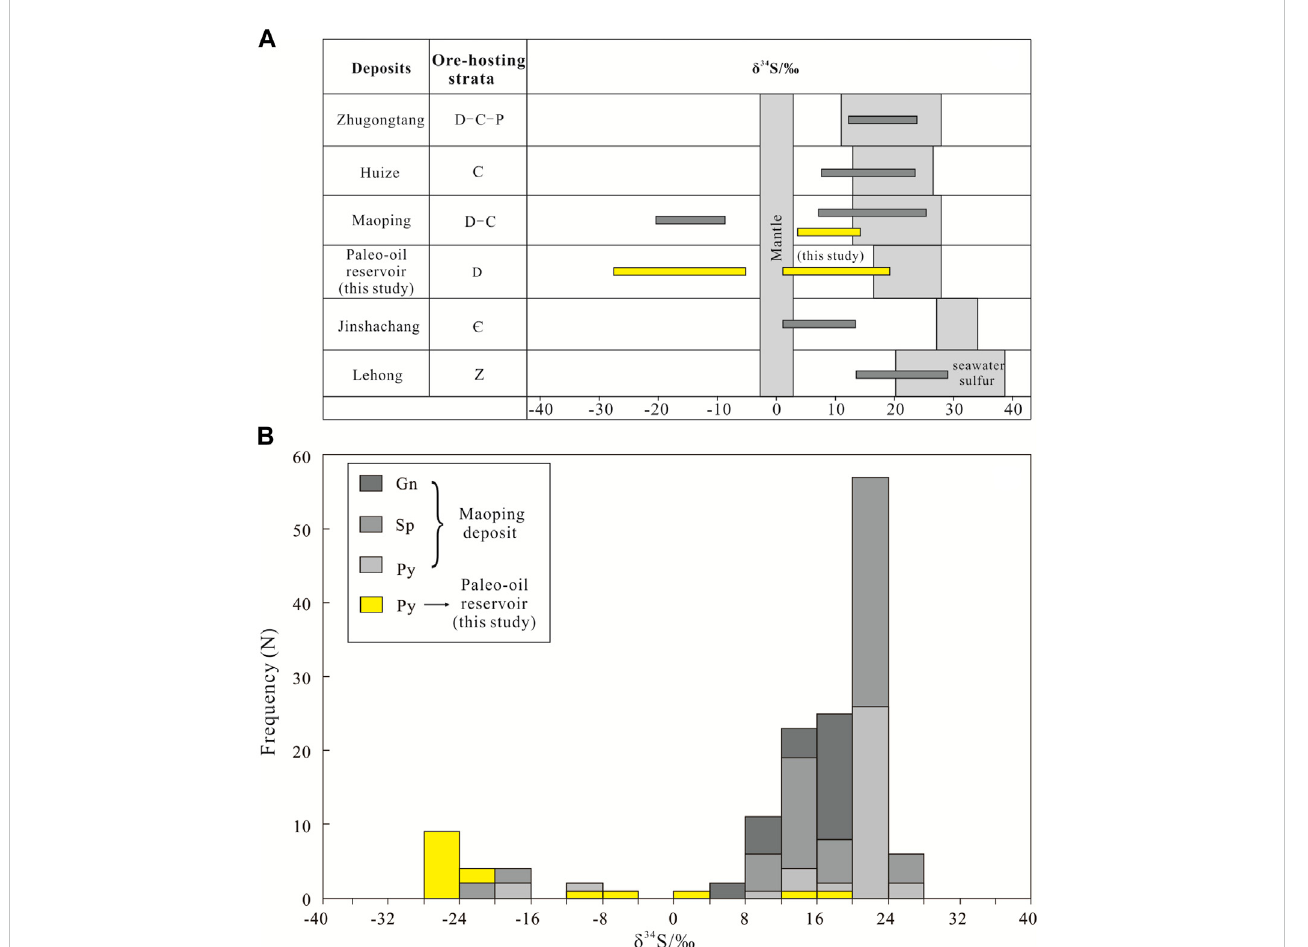
FIGURE 10 (A) ComparisonofSisotopiccompositionsbetweenthePb – ZndepositshostedindifferentstrataagesoftheNYGD,thesul fi deofthepaleo-oilreservoir, and the seawater and mantle-derived sulfur; (B) Histogram of the sulfur isotope frequency distribution of sul fi de in the Maoping Pb – Zn deposit and paleo-oil reservoir. Data sources: mantle-derived sulfur is from (Chaussidon and Lorand, 1990); seawater sulfur is from (Claypool et al., 1980); and ore deposit sulfur is from (Han et al., 2007; Zhang et al., 2014; Zhou et al., 2015; Ren et al., 2018; Wang, 2018; Tan et al., 2019; He et al., 2020; Xiang et al., 2020; Wei et al.,